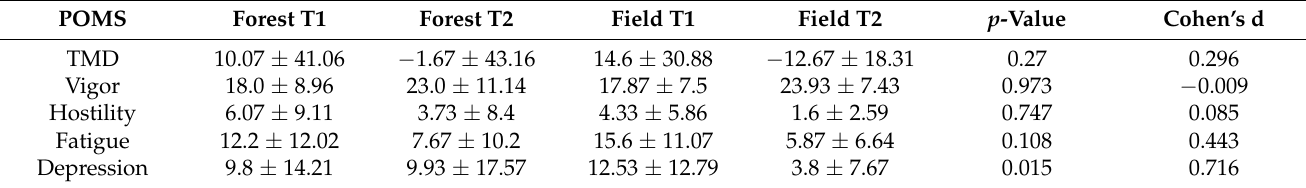
Table 4. Profile of Mood States (POMS) autumn collective ( n = 15, mean ± SD). TMD = Total Mood Disturbance.